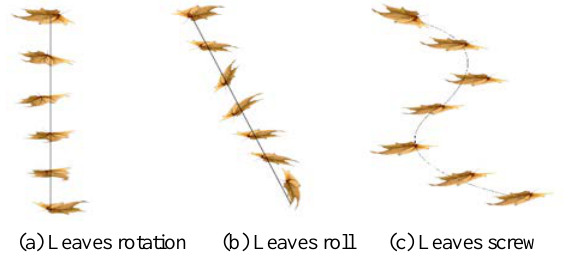
Figure 4. Leaves falling